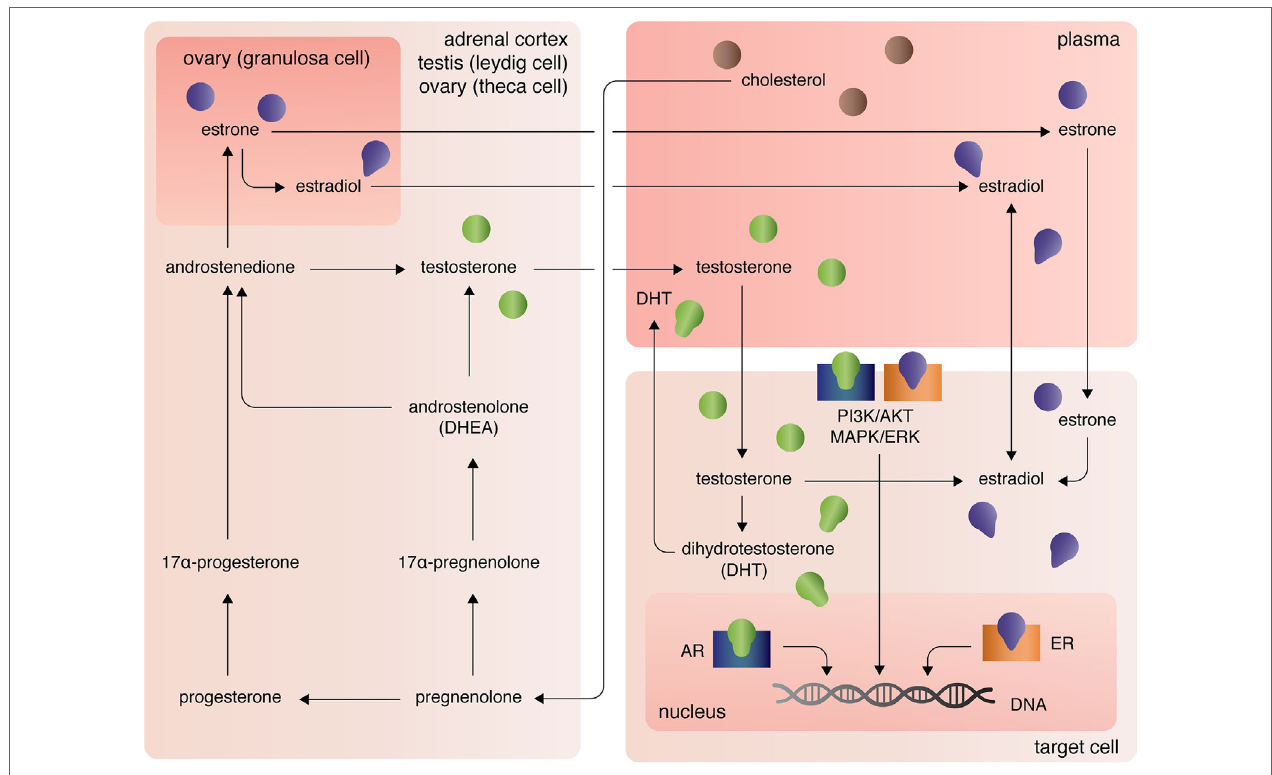
FiGURe 1 | Biosynthesis and localization of sex steroids, with a focus on estrogens and